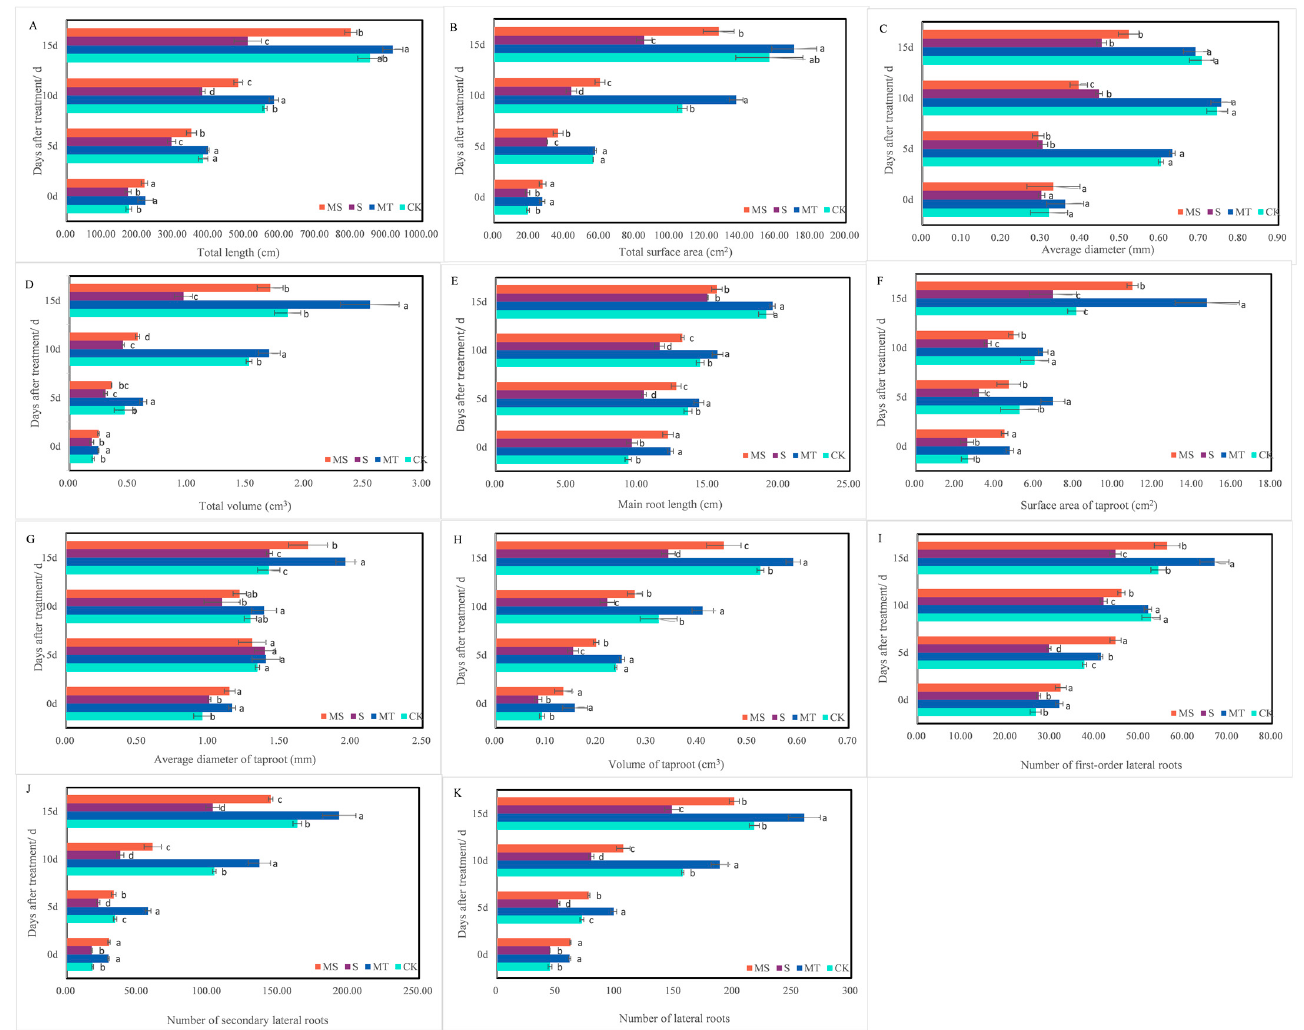
Figure 2. Effects of melatonin on cotton root morphology across treatment times. The upper parts of cotton seedlings and their root systems after treatment with control conditions (CK), melatonin (MT), NaCl (S) and both melatonin and NaCl (MS) for 15 d. ( A ): total length; ( B ): total surface area; ( C ): average diameter; ( D ): total volume; ( E ): main root length; ( F ): surface area of taproot; ( G ): average diameter of taproot; ( H ): volume of taproot; ( I ): number of first-order lateral roots; ( J ): number of secondary lateral roots; ( K ): number of lateral roots. Different lowercase letters indicate significant differences among treatments at the same timepoint ( p < 0.05).